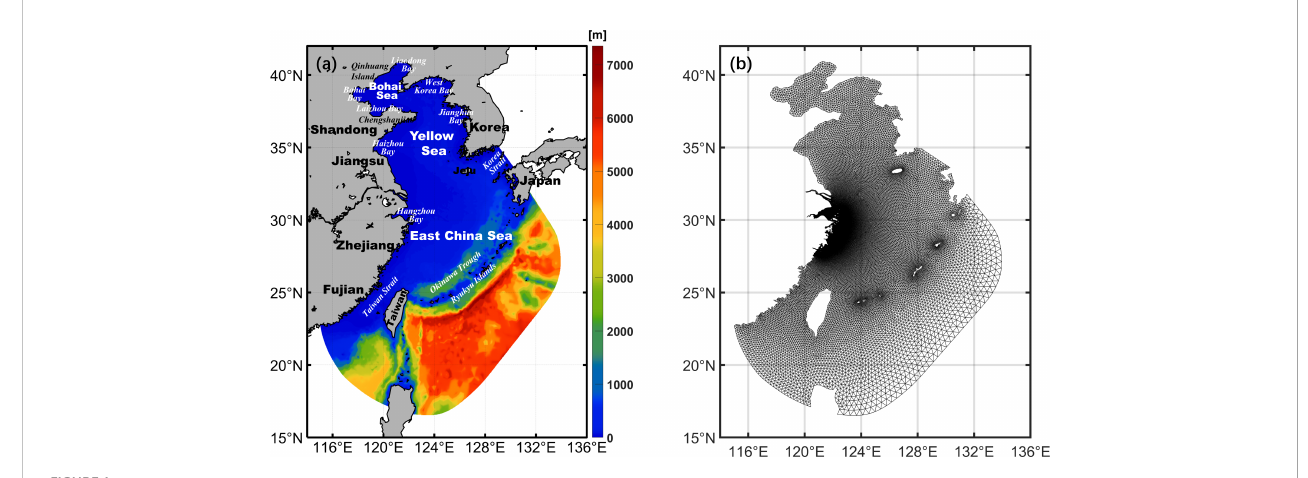
FIGURE 1 (A) Bathymetry of numerical model, (B) computational grid of study domain.